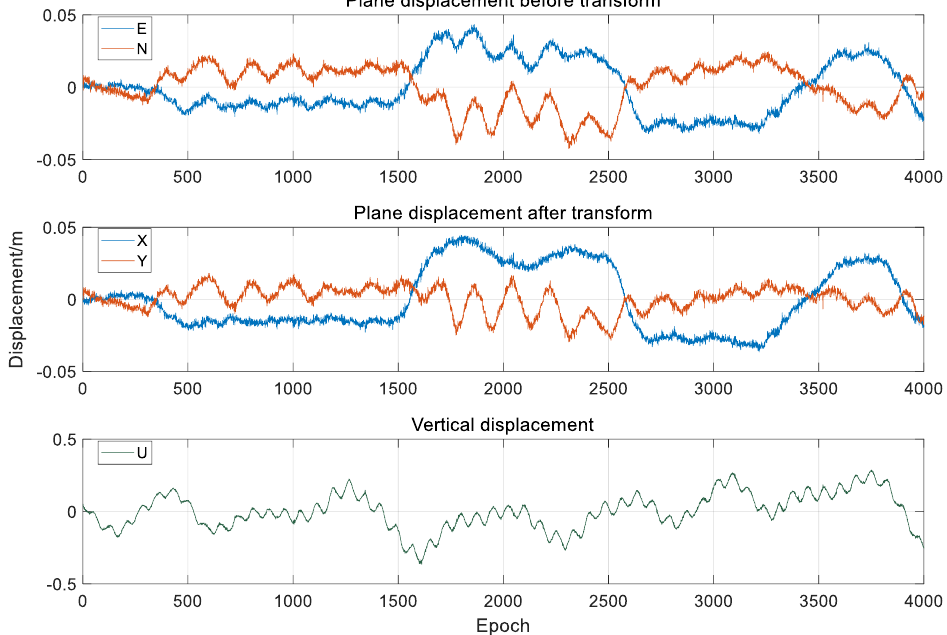
Figure 18. Comparison of displacement before and after coordinate transformation.